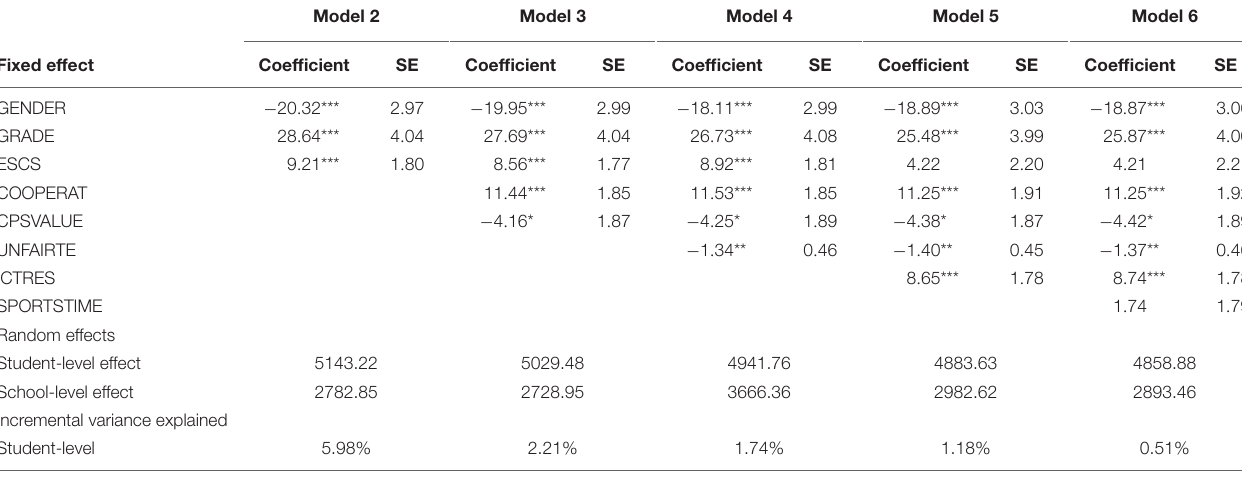
TABLE 5 | The analysis result of the student-level model (Model 2–Model 6).